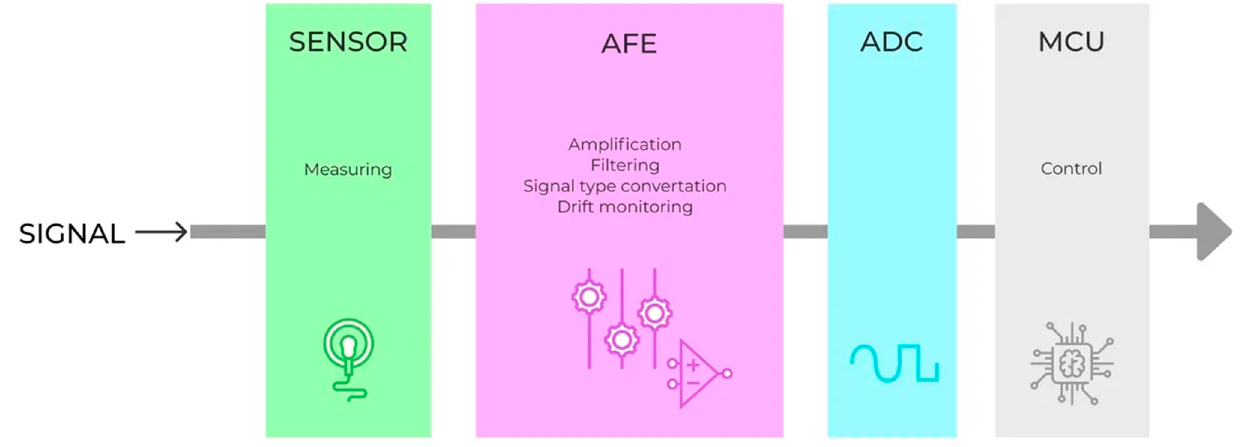
Figure 9. Place of AFE in the structure of the acquisition system.